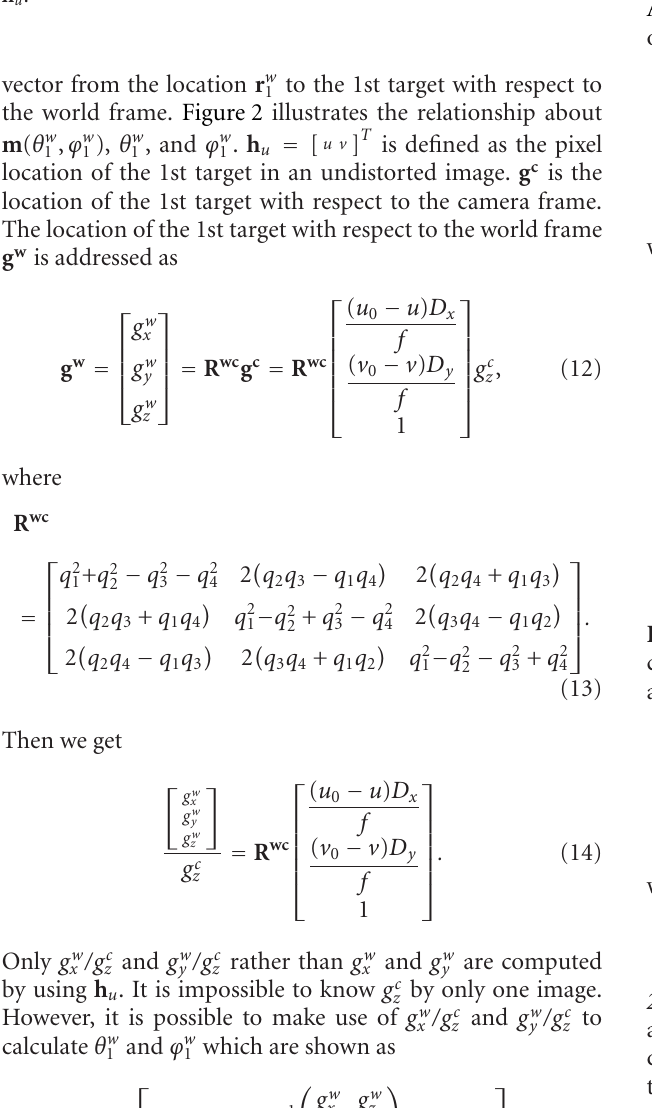
Figure 2: The orientations of the target with respect to the world frame can be estimated as a function of its undistorted pixel location h u